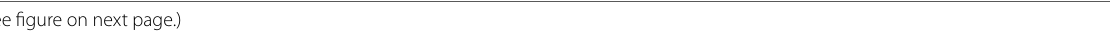
Fig. 5 a Virtual planning for an anterior zygomatic implant in an anterior maxilla ZAGA Type 4. The amount of residual alveolar bone is insufficient to host the implant. In order to respect sinus lining integrity at the ZICZ, the implant path has been buccally shifted. b Clinical picture illustrating the depth measurement of the minimally invasive ZAGA osteotomy. Note the aiming for an under‑preparation preserving as much bone as possible on both sites alveolar and maxillary wall. c The anterior ZAGA‑Flat implant is already in place. Note the micro‑threads on the implant neck opposite the flat surface. Apical self‑cutting flutes help the tapered apical portion of the implant to achieve full primary stability. d 3 and 2‑D images of the implant described in ( a )–( e ) one year later. Sinus integrity has been respected. e Esthetic prosthetic result of the upper rehabilitation and trial of the lower jaw. (Rehabilitation performed by Drs. Pedro Guitian and Elena López ZAGA Center